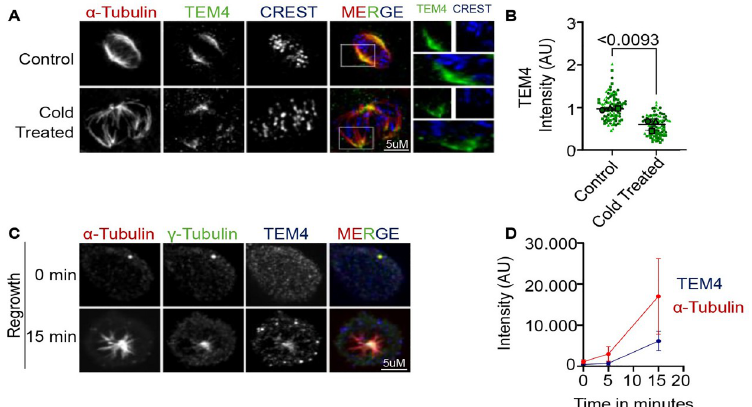
Fig 3. TEM4 antibody detects a target localized to microtubule minus ends. A: Representative Immunofluorescent image of mitotic spindles depolymerized by cold treatment. Control (upper panel) or cold treated for 20 minutes HCT- 116 cells (bottom panel) fixed with PTEMF solution and stained with anti-TEM4 (green), anti- α -tubulin for the spindle microtubules (red) and CREST serum for the kinetochores (blue). Scale bar = 5 μ m. B: Statistical analysis of TEM4 intensity at the mitotic spindle in cells from A. A minimum of 20 cells was analyzed per condition for a total of 3 independent experiments. The graph shows superplots where each biological replicate is color coded and the averages from each replicate are indicated accordingly. For all protein intensity measurements at the mitotic spindle, each dot represents a cell, and the error bars display the variation between the mean of biological replicates. Two-tailed, non- parametric Mann-Whitney test t-test was performed to compare the mean values between the tested groups. C: Immunofluorescent image HCT-116 cells treated for three hours with 3 μ M of Nocodazole. Cells were fixed with methanol after Nocodazole was washed out and cells were incubated with fresh media for the indicated time points. Fixed cells were stained with anti-TEM4 (blue), anti- α -tubulin for the spindle microtubules (red) and anti- γ -tubulin for the centrosomes (green). Scale bar = 5 μ m. D: Statistical analysis of α -tubulin and TEM4 intensity in different time points corresponding to Fig 3C.